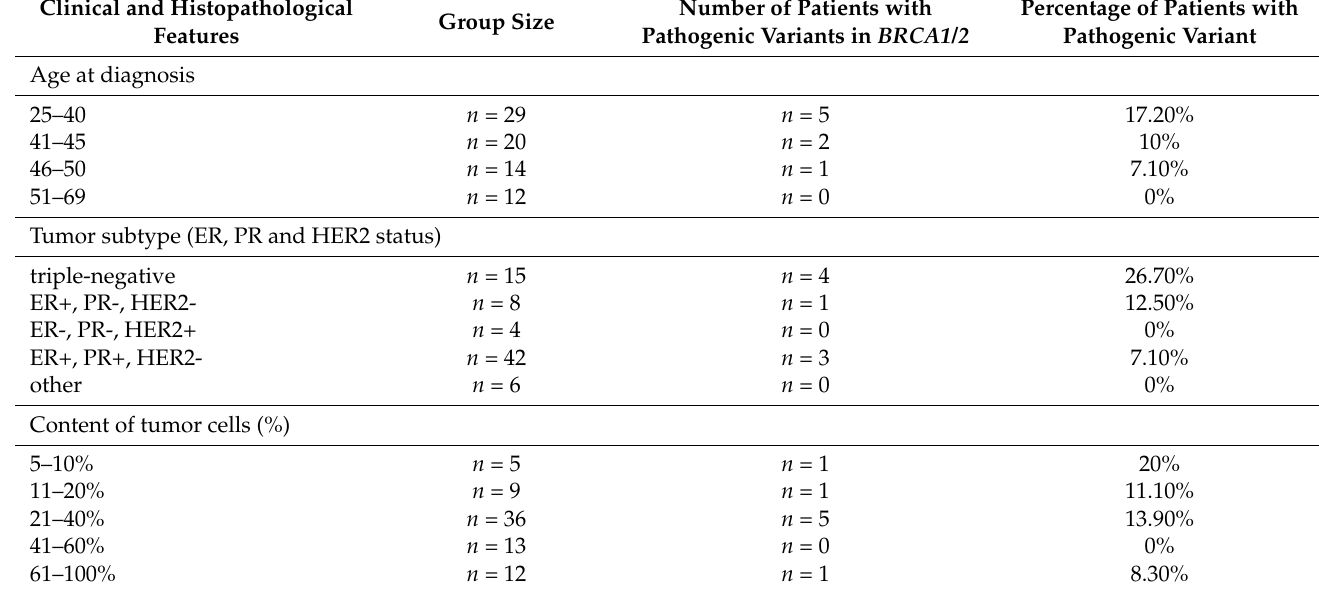
Table 2. Studied population of patients, genetically tested in 2003–2015 and negative for the presence of known mutations in the BRCA1 gene (c.5266dupC, c.181T>G, c.4035delA, c.68_69delAG, c.3700_3704delGTAAA); diagnosed with breast cancer in 2003–2015; study group: n = 75 patients with breast